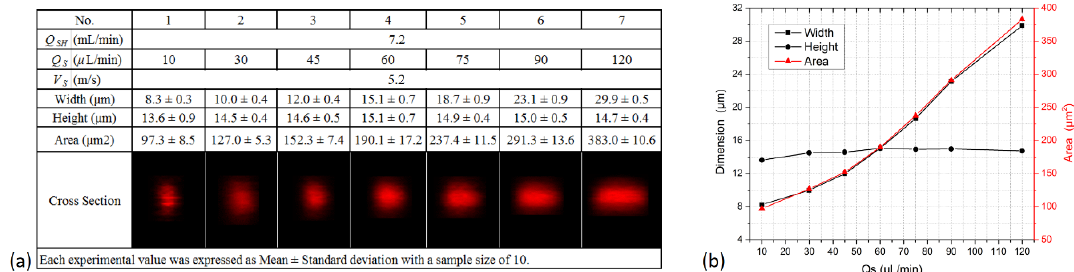
Figure 6. Experimental results of the focused sample flow when the sheath flow increased from 3.6 to 9.6 mL/min (or the sample flow velocity increased from 2.6 to 6.8 m/s), as shown in the table ( a ) and the figure ( b ).